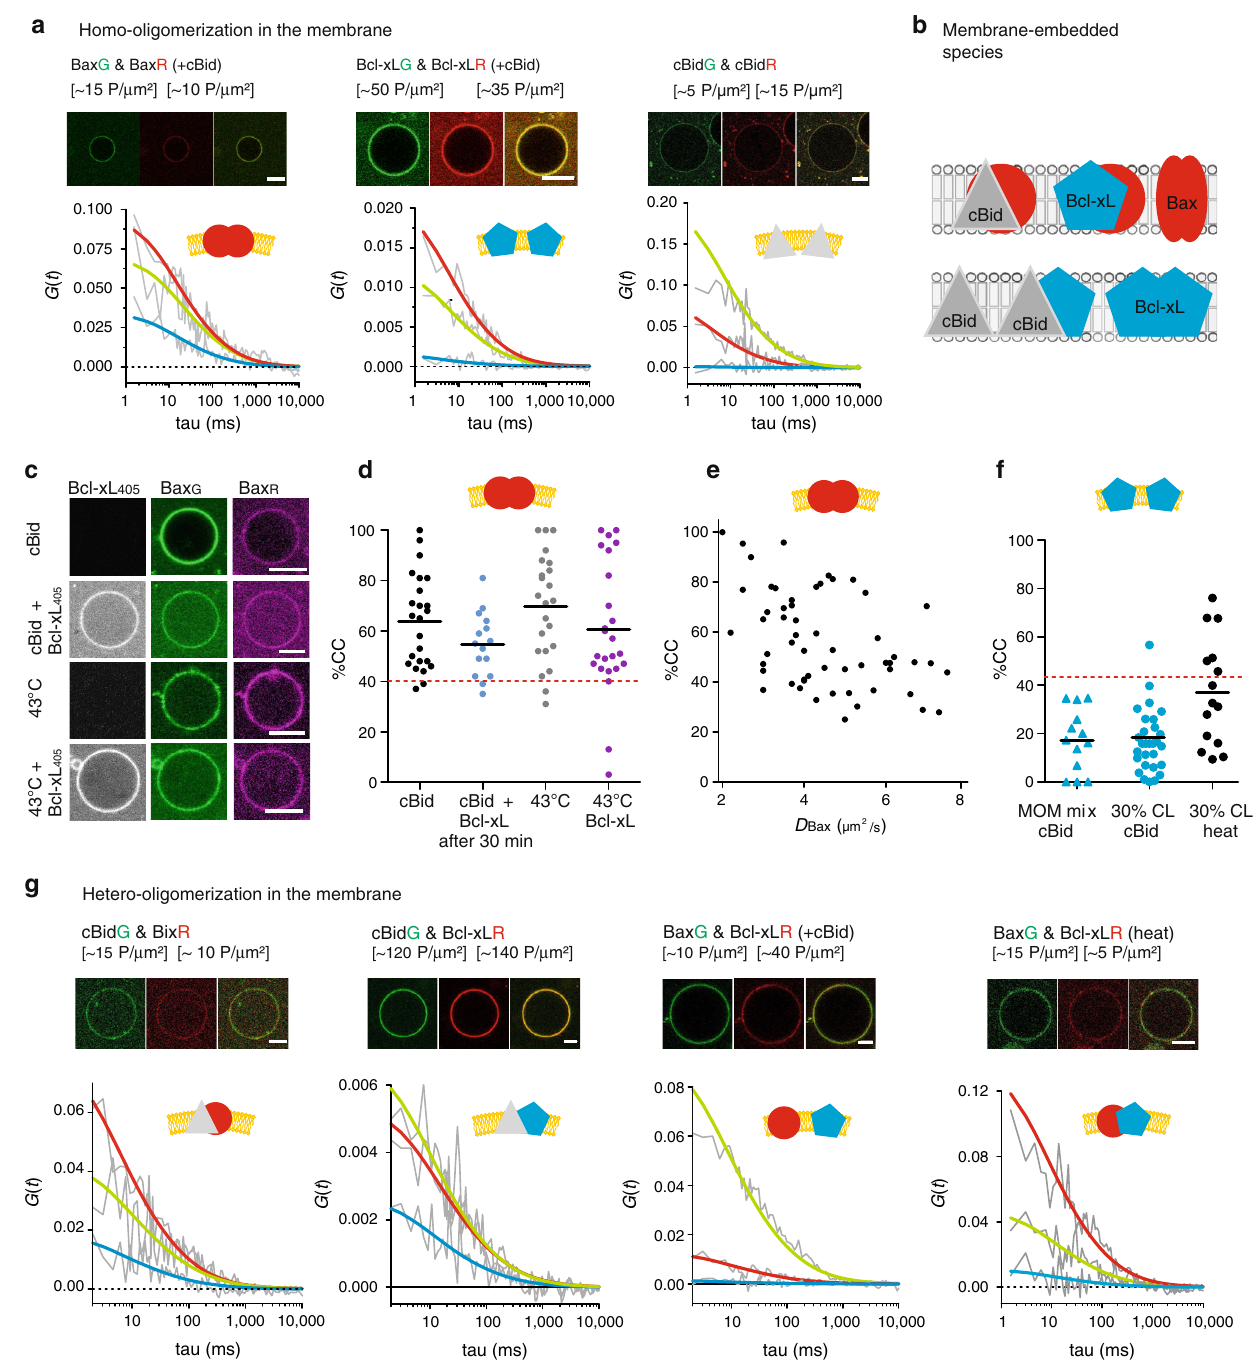
Fig. 4 Analysis of the interactions between cBid, Bax and Bcl-xL within membranes. a Representative FCCS graphs and corresponding GUV images of cBid, Bax, and Bcl-xL homo-oligomerization in membranes (30% CL, Scale bar: 10 µ m). Only the Bax G /Bax R pair presents positive CC amplitude indicative of interaction. The AC and CC curves are shown in grey , whereas the fi tted curves are shown in green (green protein), red (red protein), or blue (complex). b Scheme of the different species that can be detected in the membrane. c Representative images of Bax R , Bax G , and Bcl-xL 405 binding to GUVs (30% CL, Scale bar: 10 µ m) in presence of unlabeled cBid or after incubation at 43 °C. d Comparison of the oligomerization expressed as %CC between Bax G and Bax R in individual GUVs after activation by cBid or 43 °C and in presence or absence of Bcl-xL 405 (30% CL; n = 4). All data are from one batch of labeled Bax to ensure that the degree of labeling is the same under all conditions. The maximal possible %CC for dimer formation considering the degree of labeling and a Mendel-based distribution of red – red , red – green , and green – green complexes is indicated by the dotted red line . e Relationship between CC and D of Bax G and Bax R activated by cBid in individual GUVs (30% CL; n = 5 independent experiments using three independent Bax batches; degree of labeling 80 – 100%). The CC values of three experiments were already published in ref. 19 (see also Supplemental Fig. 8A – C). f Comparison of the CC between Bcl-xL G and Bcl-xL R in GUVs composed of the both lipid mixtures. Membrane insertion was induced by cBid or 43 °C. The dotted red line indicates the maximal %CC possible considering dimer formation ( n = 3). Only one protein batch was used due to the same reasons as in d . Data from independent Bcl-xL batches are shown in Supplemental Fig. 8A, B. g Representative FCCS graphs and corresponding GUV images of cBid, Bax, and Bcl-xL hetero-oligomerization in GUVs (30% CL; Scale bar: 10 µ m; color code as in a . FCCS fl uorescence cross correlation